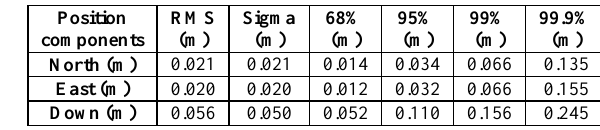
Table 1: Position Difference Statistics, PP-RTX vs. ASB